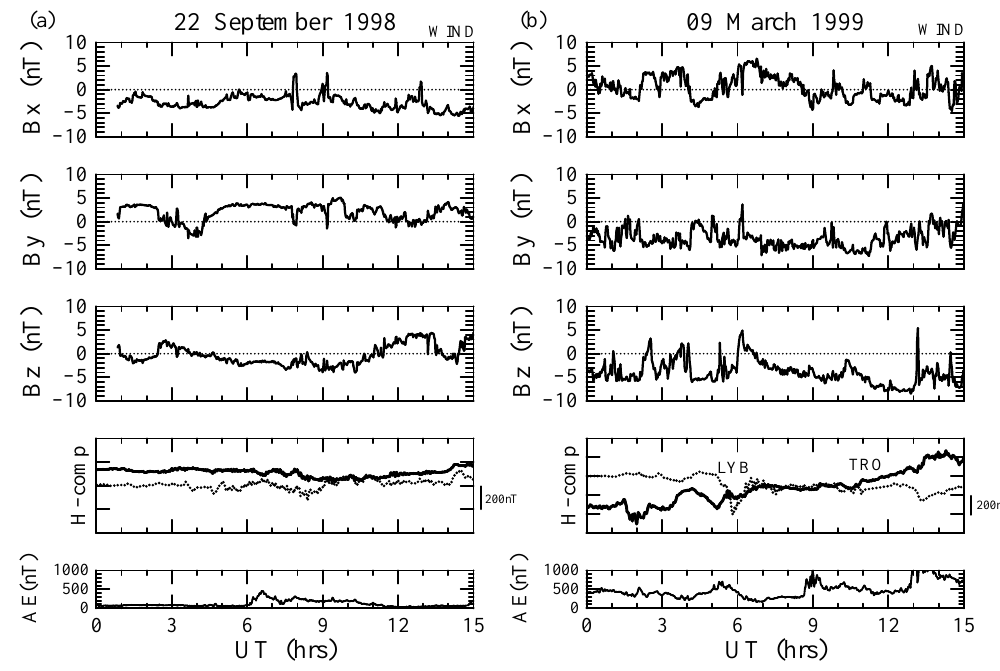
Fig. 1. From top to bottom: IMF B x , B y and B z measured by the WIND spacecraft upstream in the solar wind, H -component of the magnetic field at Tromsø (TRO) and Longyearbyen (LYB) and AE -index on 22 September 1998 and 9 March 1999. The IMF data are corrected for a propagation delay from WIND and the Earth’s